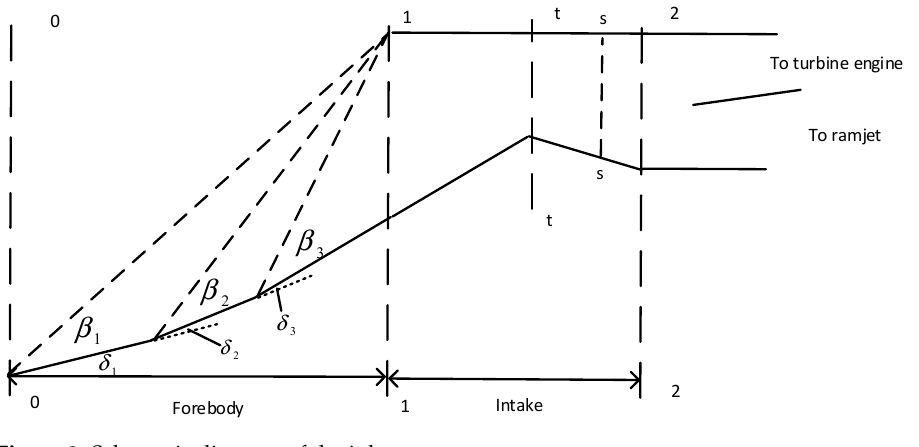
Figure 2. Schematic diagram of the inlet.